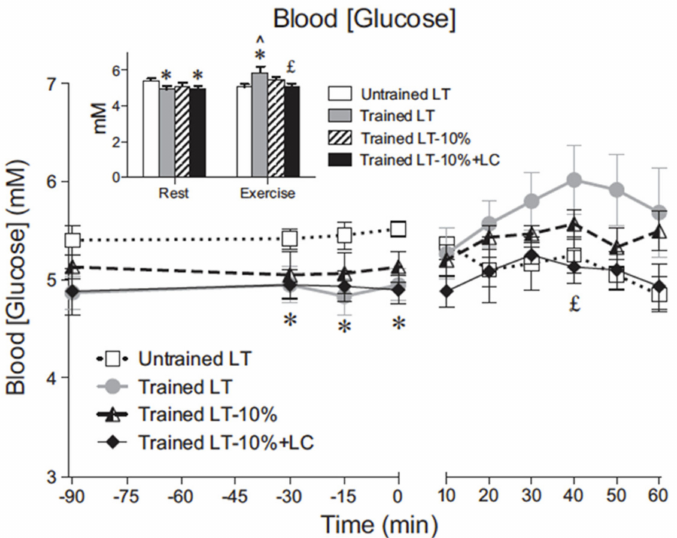
Figure 1. Blood glucose concentration across time in resting and exercising young men. Values are means ± SE; n = 6 for untrained and trained groups. The inset shows steady-state rest and exercise glucose concentrations for each condition. LT, lactate threshold; LT-10%, 10% below the LT workload; LT-10% LC, 10% below the LT workload with a lactate clamp. ˆ Significantly di ff erent from rest within condition ( p < 0.05). * Significantly di ff erent from untrained ( p < 0.05). £ Significantly di ff erent from trained LT ( p < 0.05). Note that even in the young healthy cohort regular physical exercise (training) significantly decreases resting, 12 h, overnight fasted blood (glucose). Note also that in trained men blood (glucose) increased during hard exercise at the lactate threshold (LT), but that exogenous lactate infusion (lactate clamp, LC) decreases blood (glucose). From